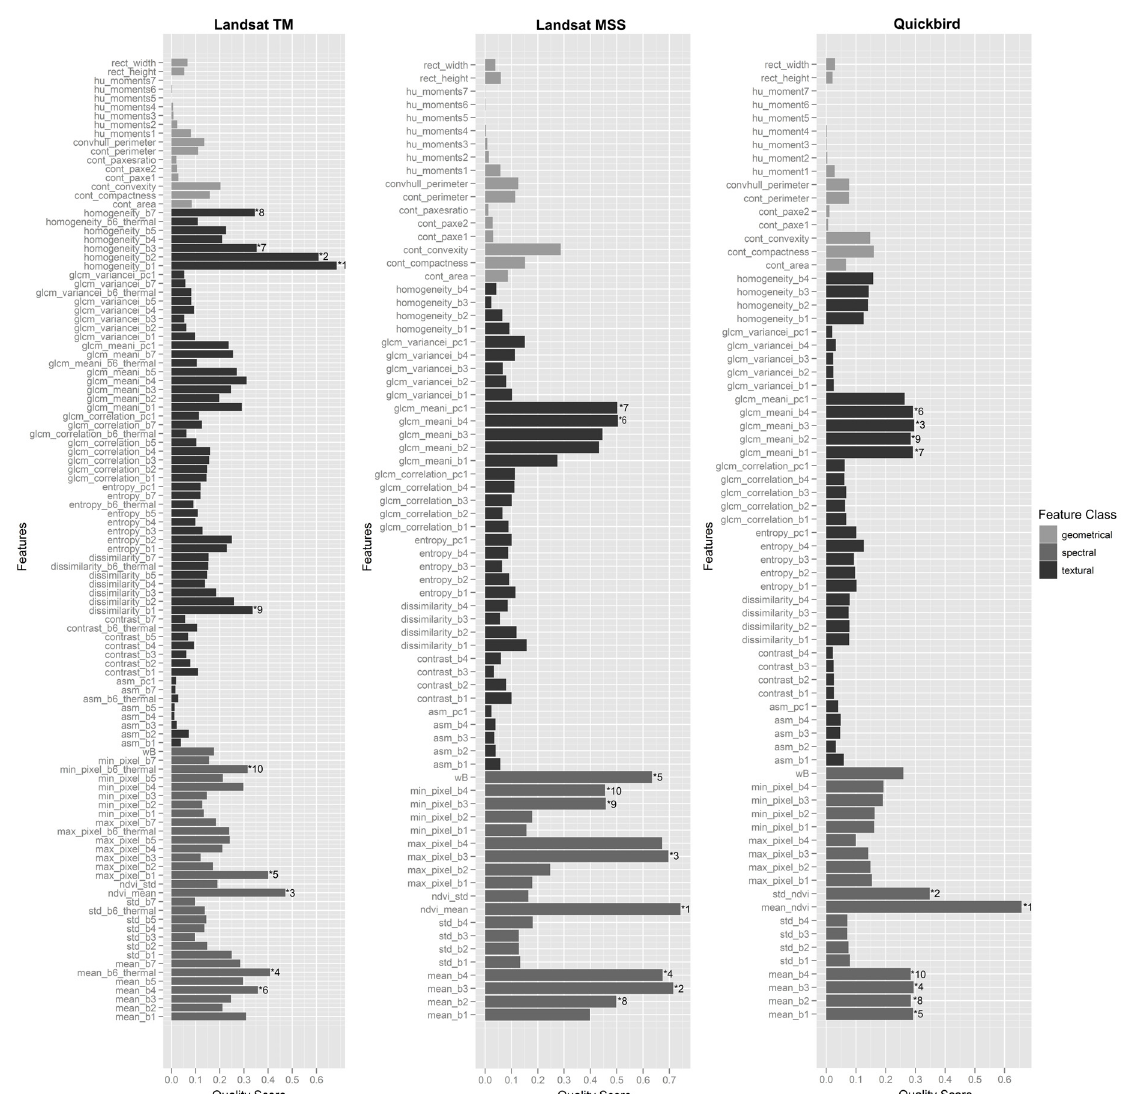
Figure 2. Features for the Landsat Thematic Mapper (TM), Landsat Multi-Spectral Scanner (MSS) and Quickbird (QB) reference dataset grouped into spectral, textural and geometrical features and ranked by their importance for distinguishing built-up from not built-up areas. For each image type, the ten most important features are highlighted. A description of the features can be found in Tables 2 and